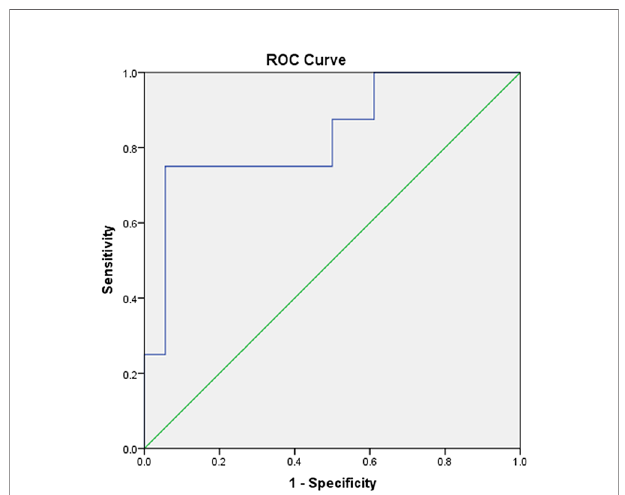
FIGURE 2 | A receiver operating characteristic curve for measuring the accuracy of the SUV max as a parameter for distinguishing pulmonary ACTH- secreting tumors from pulmonary infection. The area under the curve is 0.833. A cut-off SUV max of 4.95 or greater is predictive of pulmonary infection with 75% sensitivity and 94.4% speci fi city.